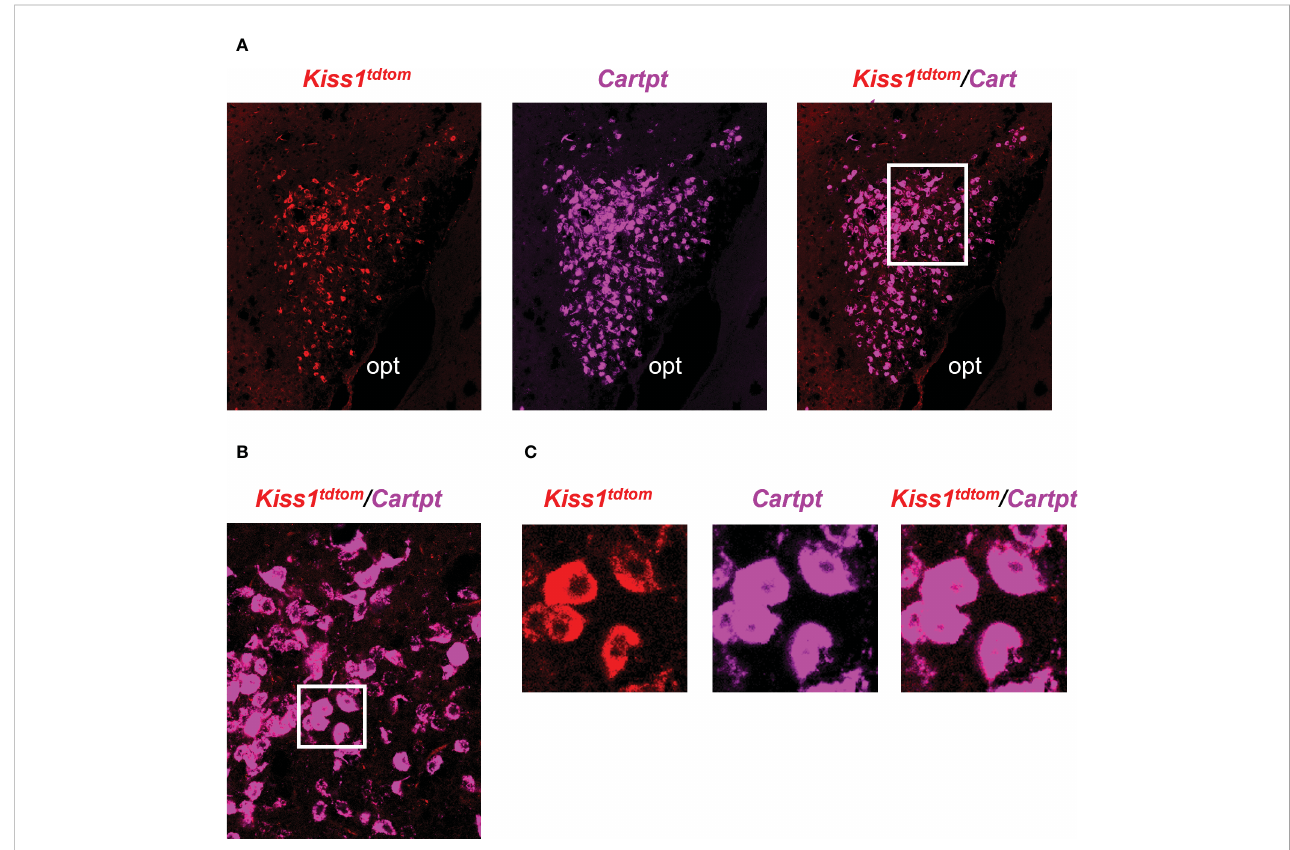
FIGURE 5 Double-label IHC/ISH of Kiss1 TdTomato cells and Cartpt in the medial amygdala of an E 2 -treated female mouse. (A) A representative image of Kiss1 TdTomato cells (red) and Cartpt (purple) of an E 2 -treated female mouse. (B, C) Higher magni fi cation images of the area in the white box showing a high degree of Cartpt (purple) expression in Kiss1 TdTomato cells (red). opt = optic